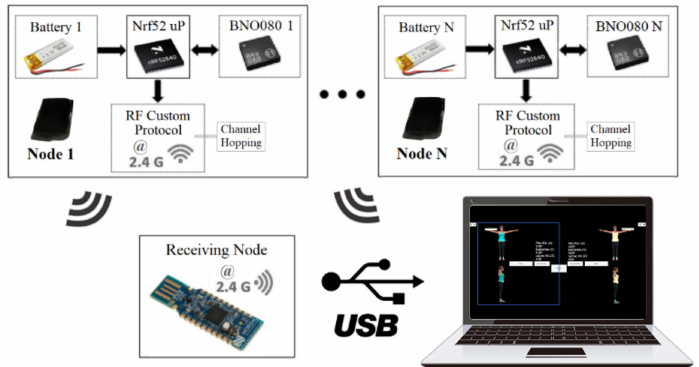
Figure 2. Communication between the CW sensors and the USB dongle attached to a computer.